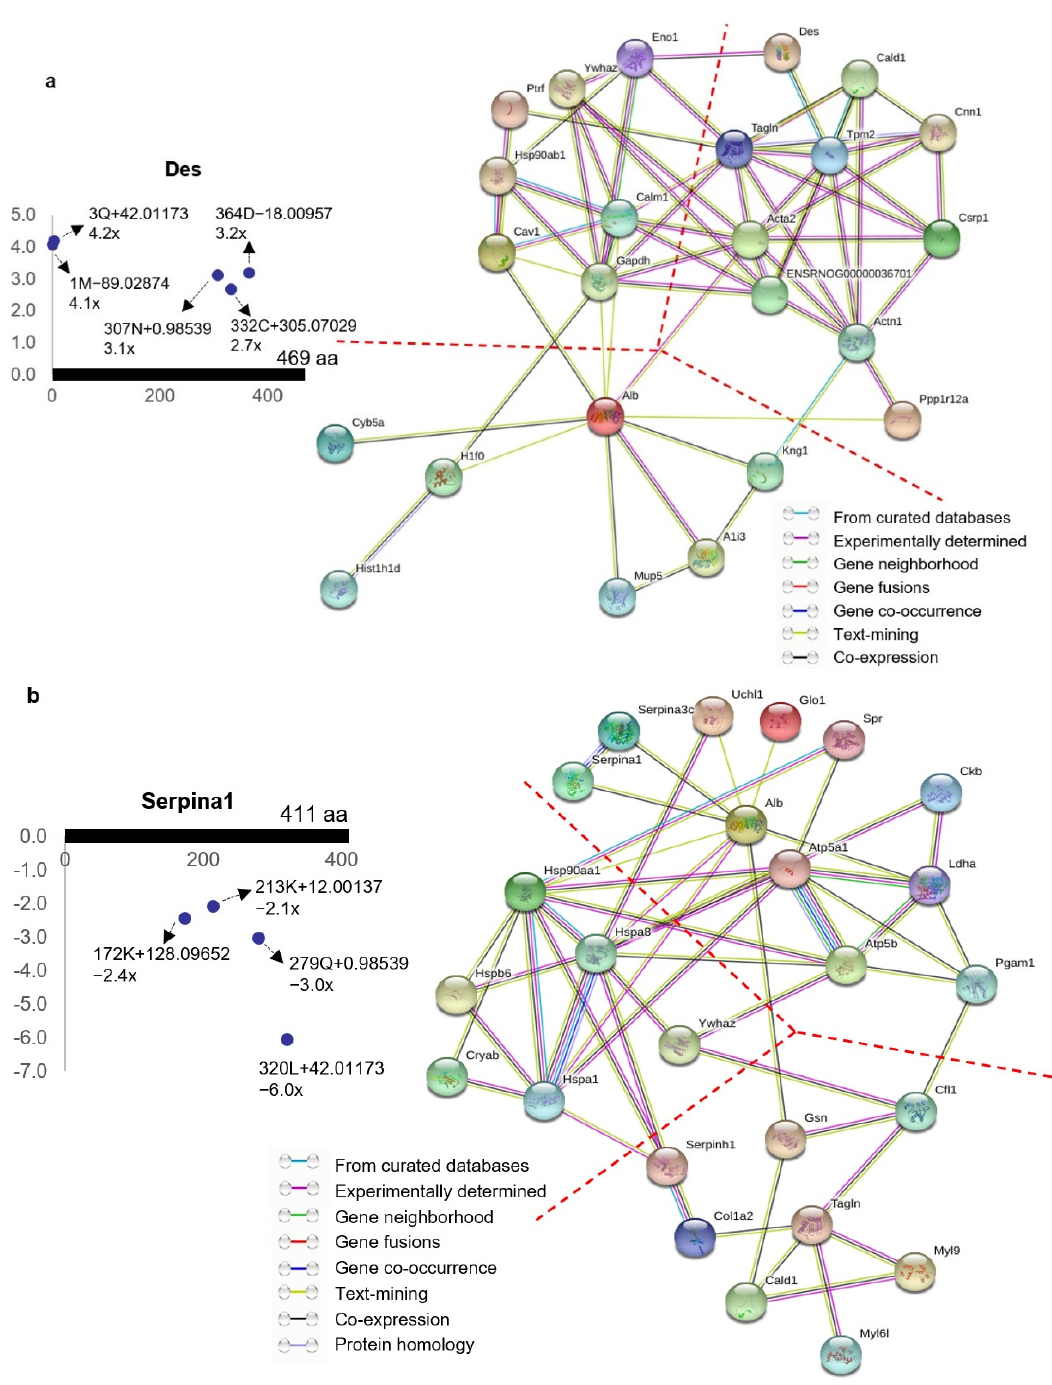
Figure 5. Protein–protein interaction networks of ischemia-associated ncAA-containing proteins. Network nodes and edges represent proteins and protein–protein associations, respectively. The color of the network edge indicates the type of interaction evidence. ( a ) Protein–protein interaction networks formed between 30 upregulated ischemia-associated ncAA-containing proteins (R 2 > 0.5, ratio > 2, p < 0.05). Each protein had upregulated ischemia-associated ncAAs. Des is shown as an example. The annotation information of each dot, which represents ncAA, is as follows: modified (protein) position, modified amino acid residue, delta mass and ratio of modification. The horizontal axis represents the amino acid position of Des; the vertical axis represents the ratio of modification. The interaction networks were broadly divided into three clusters: cell signaling-related proteins (left), cytoskeleton-associated proteins (right), and binding/transport-related proteins (bottom) (24 connected proteins were shown and the clusters were divided with dotted lines). The possible modification for each nonzero delta mass is as follows: 42.01173: acetylation, S > E; − 18.00957: E > pyro-E, dehydration; − 89.02874: removal